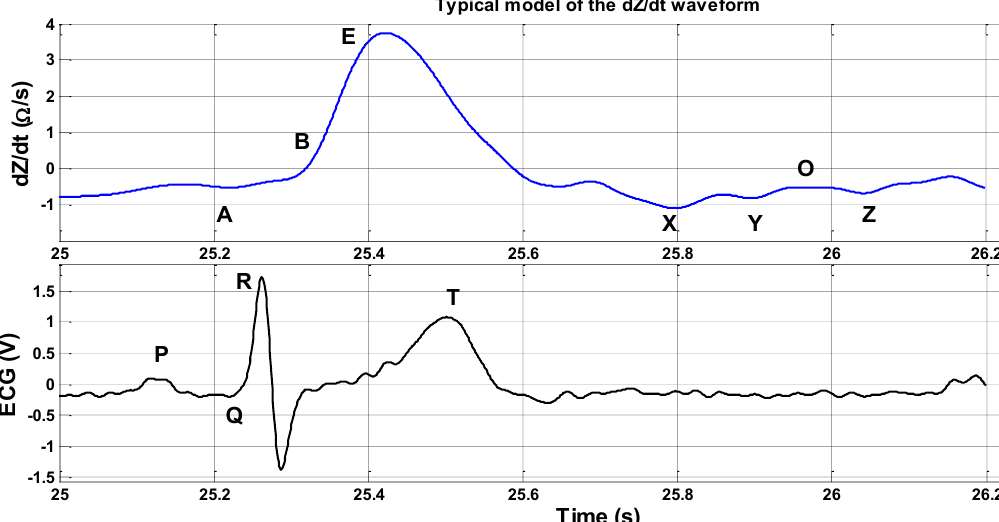
Fig. 1: Typical model of dZ/dt waveform recorded simultaneously with an ECG signal. Each signal is marked by characteristic